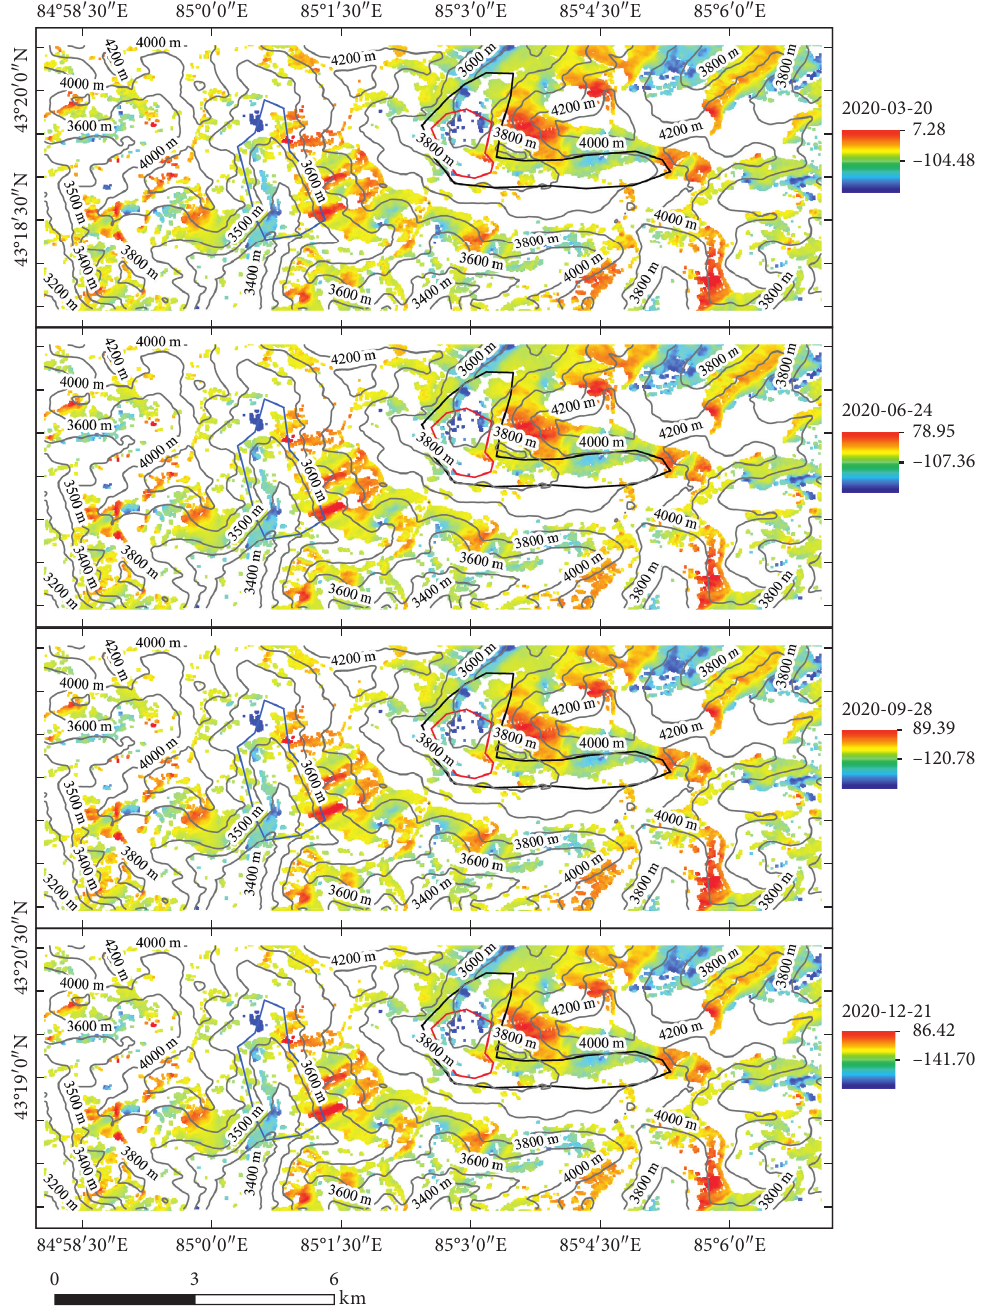
Figure 10: LOS deformation of 2020, in